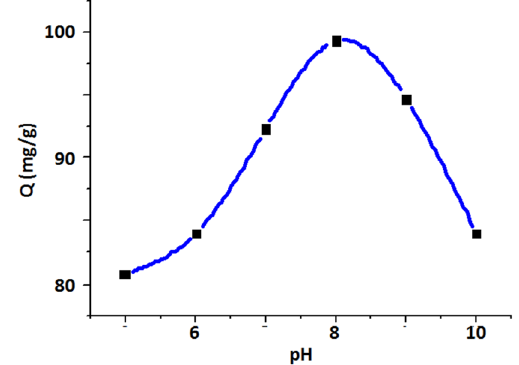
Fig. 2 Amounts of AG1 retained by [Zn–Al–Cl] at different pH val- ues